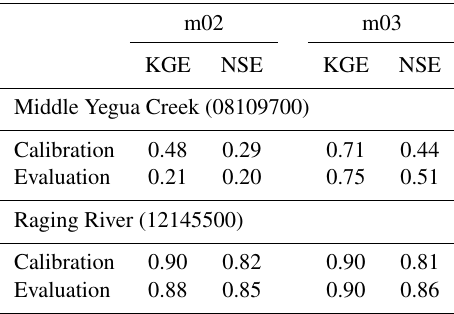
Table 2. Nash–Sutcliffe efficiency (NSE) scores found when cal- ibrating a single optimal parameter set for each combination of model and catchment, using data from 1 January 1989 to 31 Decem- ber 1998 for calibration and data from 1 January 1999 to 31 Decem- ber 2009 for evaluation. The calibration and evaluation KGE scores listed in Fig. 1 (obtained using identical periods for calibration and evaluation) are shown for